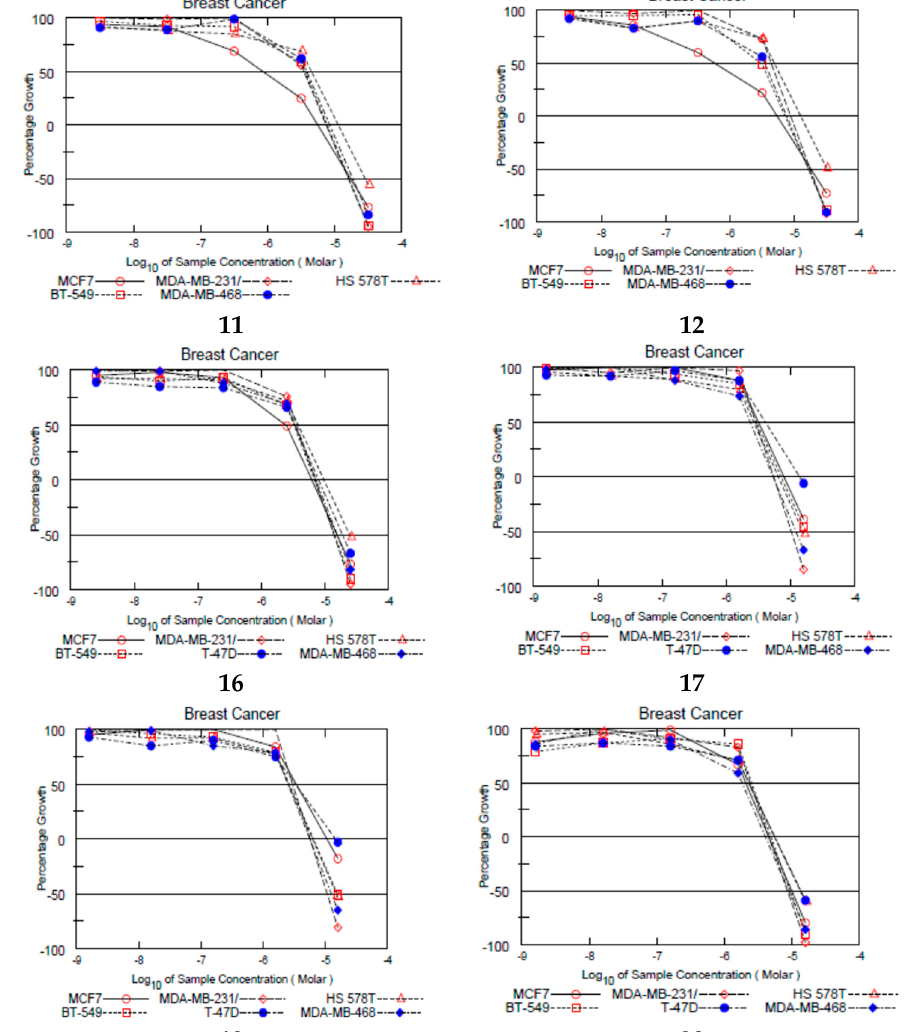
Figure 2. Dose-response curves of selected compounds on breast cancer cell lines. Data obtained from NCI in vitro disease-oriented human tumor cell screen (for details, see the work of [39]) compounds were tested in